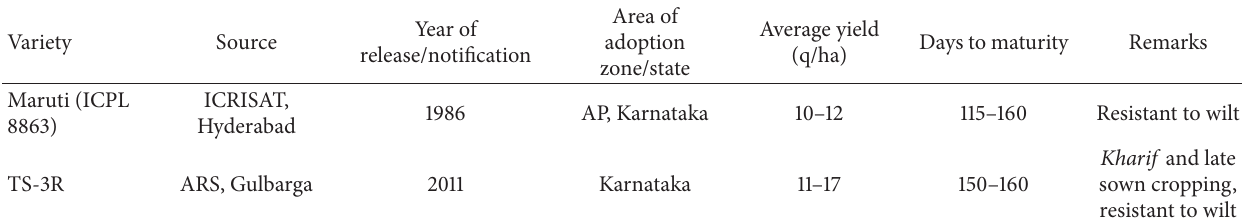
Table 3: The major characteristics of varieties used in pigeonpea.